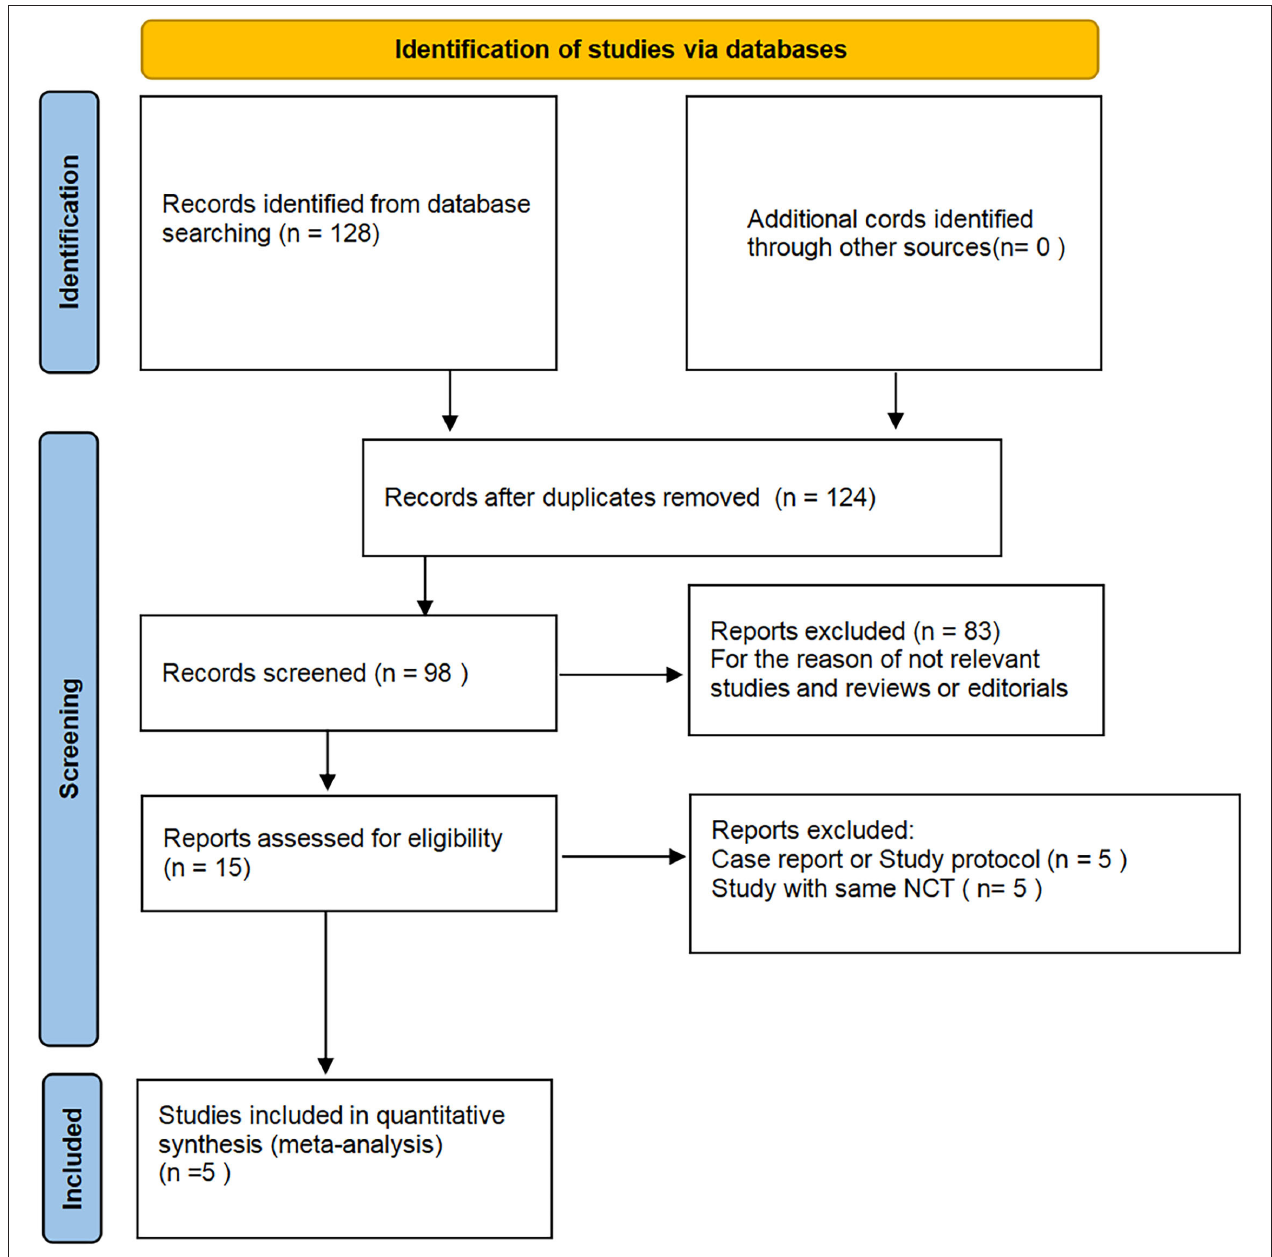
FIGURE 1 | Flowchart of database search and study